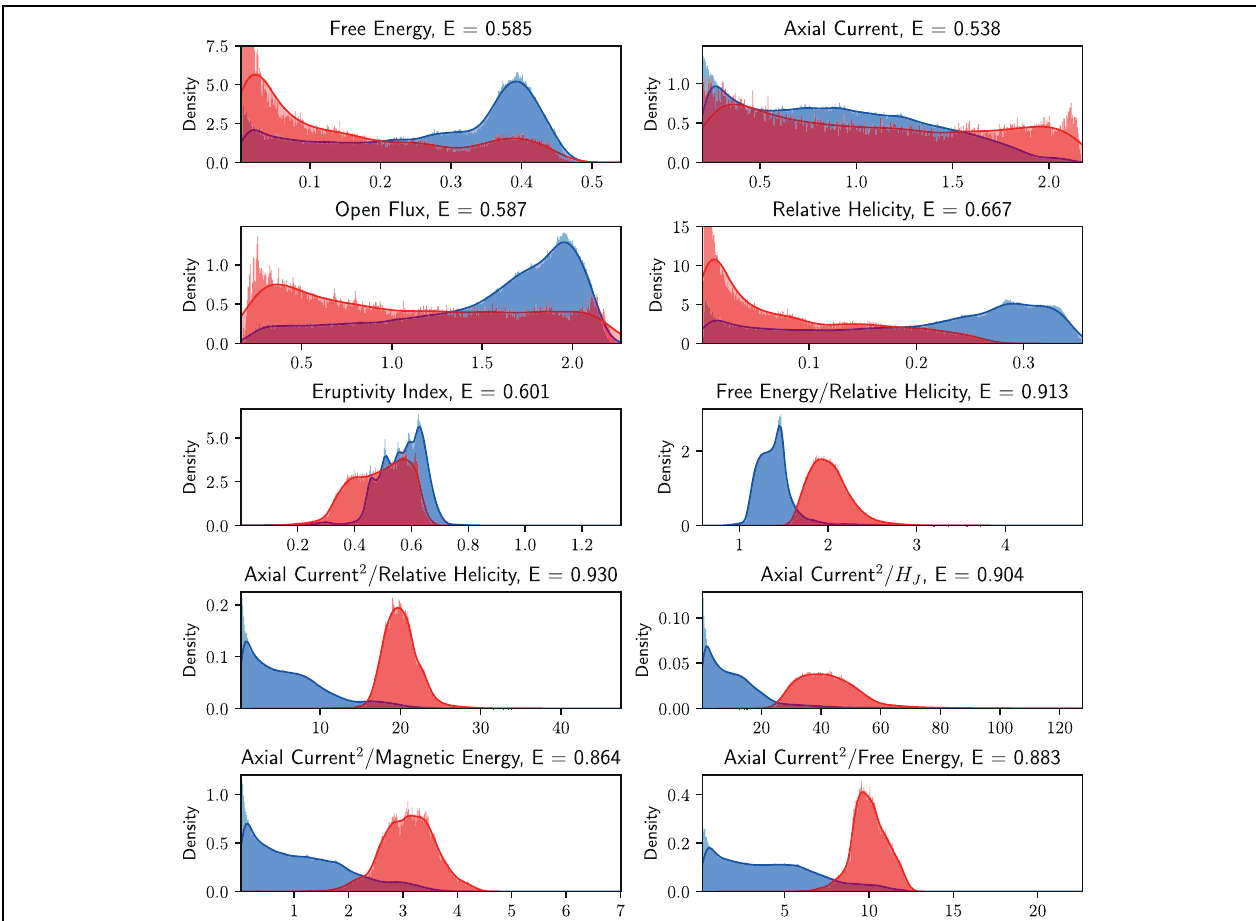
FIGURE 9 | Histograms of five of the diagnostic parameters, and five of the ratios between them. The points that precede an eruption within t = 0.3 time units are shown in red, and those that do not are shown in blue. The diagnostics with less red/blue overlap are better predictors of eruptions and vice versa. The eruptivity skill score E is given for each diagnostic. The curves are normalised to have an area of